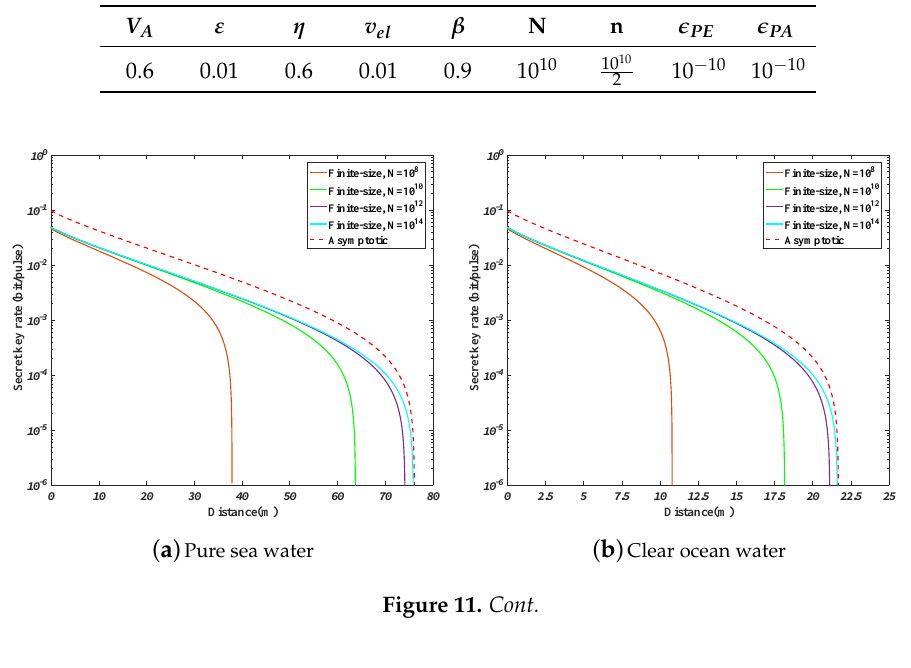
Table 2. Parameters setting of the system in the finite-size scenario.